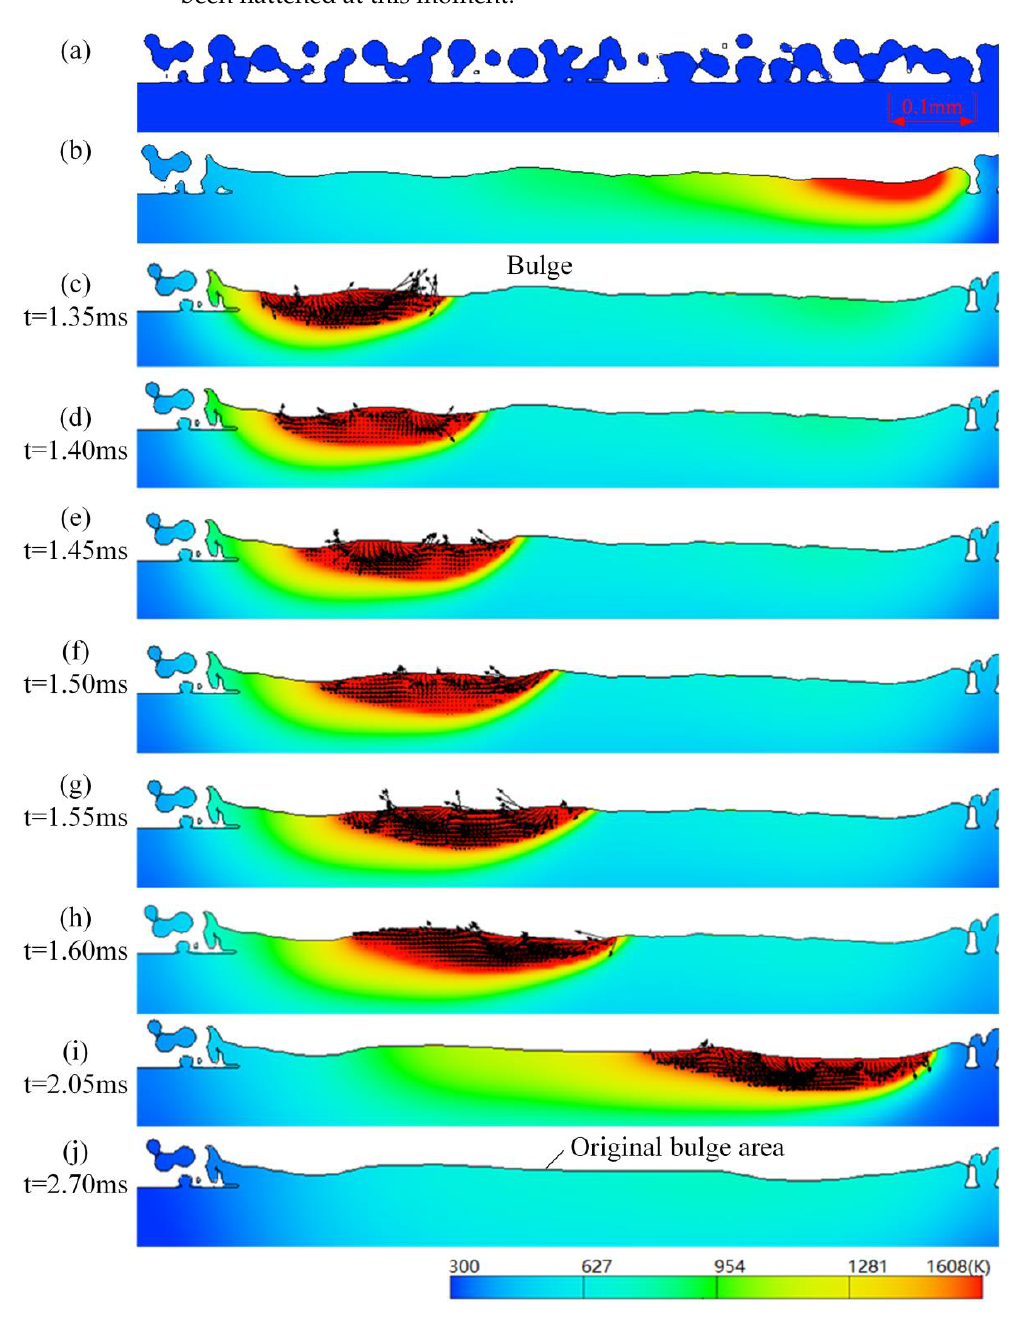
Figure 11. Surface topography evolution. ( a ) Powder bed; ( b ) surface profile after SLM; ( c – j ) are the ILP process. The parameters of SLM were 150 W, 0.8 m/s and 0.05 mm (power, speed and spot diameter). The parameters of ILP were 130 W, 0.8 m/s and 0.05 mm (power, speed and spot diameter). The entire domain is 1 mm long and 0.15 mm